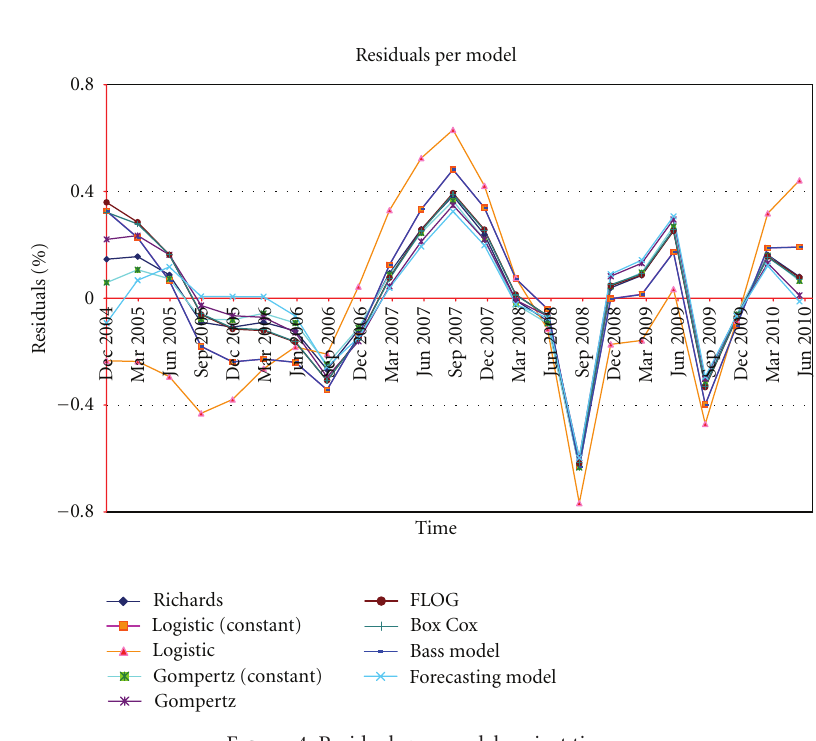
Figure 4: Residuals per model against